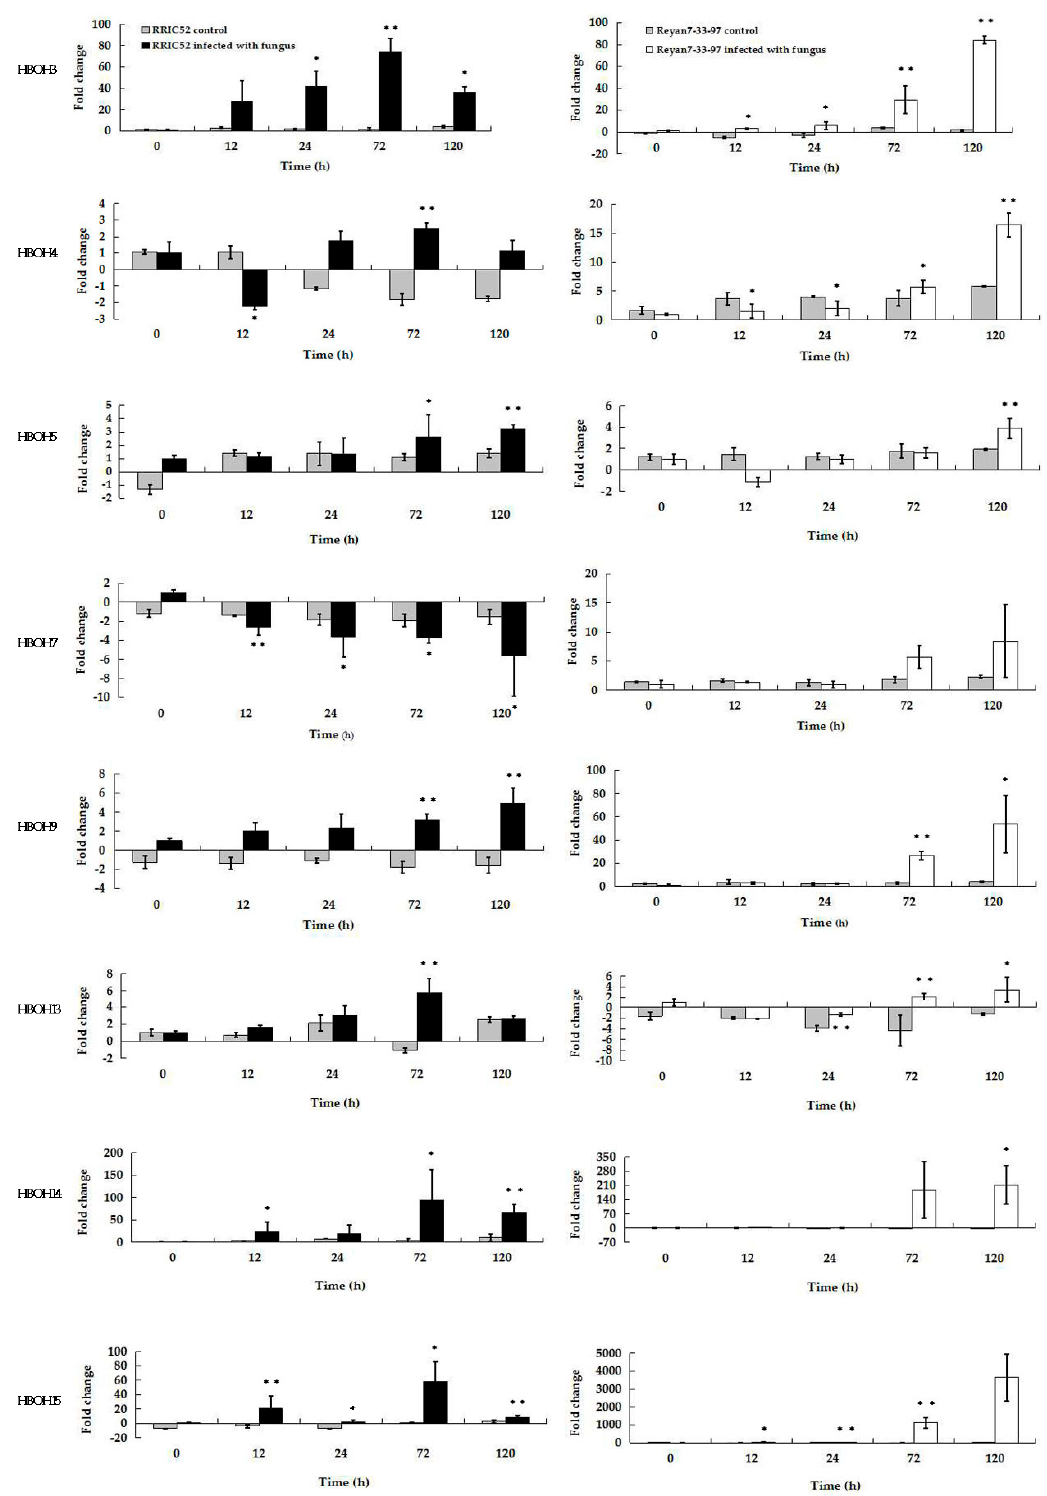
Figure 4. qRT-PCR analysis of eight EST expression levels in RRIC52 and Reyan 7-33-97 leaves during powdery mildew infection. Leaf samples were collected at 0, 12, 24, 72 and 120 hpi. Each gene expression level during the course of infection was compared to that at 0 hpi by the Pfaffl method [10], using RH8 and YLS8 in rubber tree as the reference genes; leaf samples from uninoculated plants of the same age were used as controls for each time point. Three biological replicates per cultivar were averaged and statistically analyzed using Student’s t -test (* indicates p < 0.05. **, p < 0.01) between control and powdery mildew-inoculated leaves. Bars indicate ± S.E. from the results of three biological replicates.